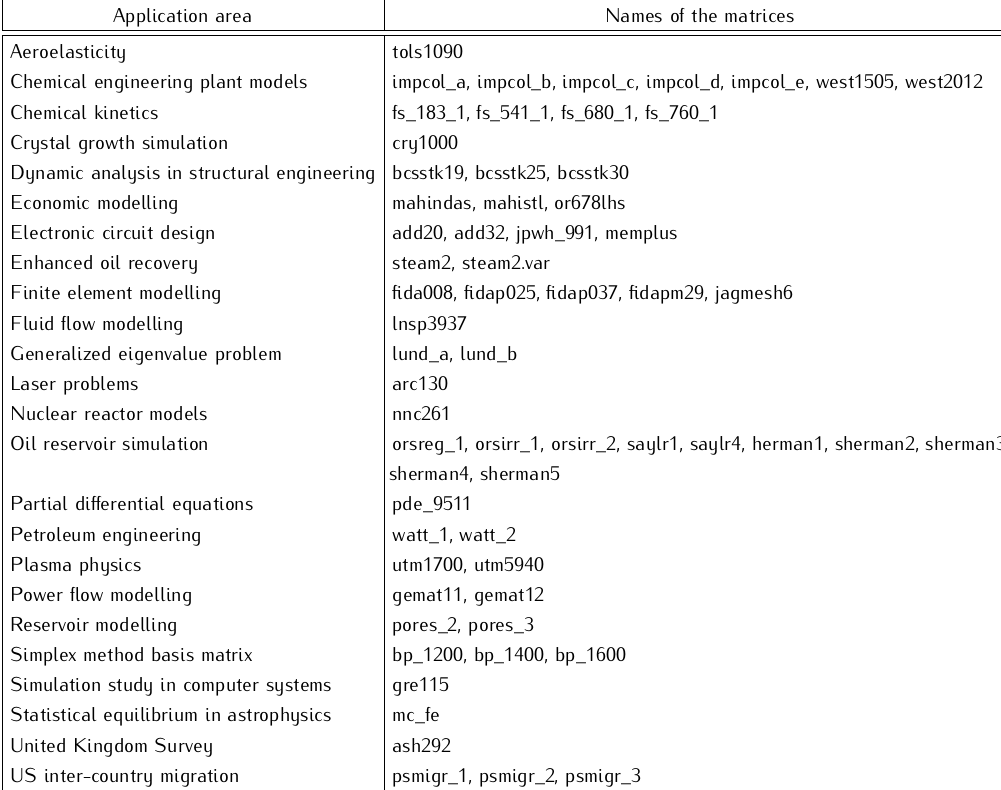
Table 3. Application areas and names of 64 matrices selected from the Sparse Matrix